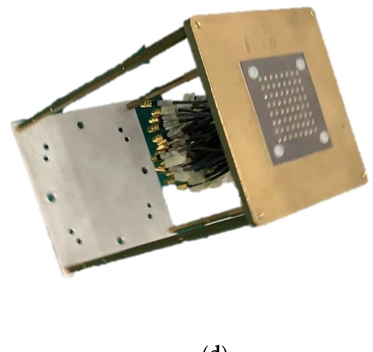
Figure 3. Two antenna subarray structures. ( a ) 2–18 GHz ultra ‐ broadband subarray structure. ( b ) 26–40 GHz microstrip antenna subarray structure. ( c ) 2–18 GHz Physical picture and test status of antenna array. ( d ) 26–40 GHz Physical picture and test status of antenna array.